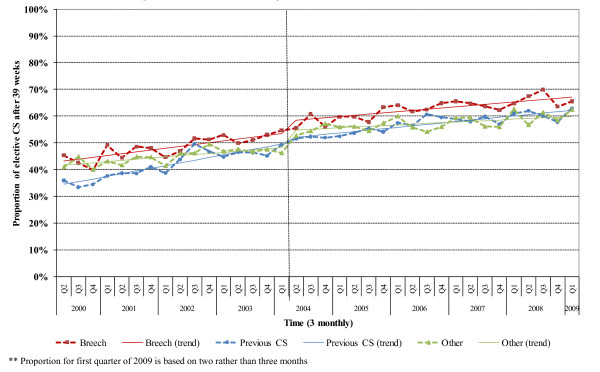
Trends in the rate of elective caesarean sections delayed performed after 39 weeks, by the two main indications for elective caesarean section. Fitted line shows the predicted effect of the NICE guideline on the individual rates.